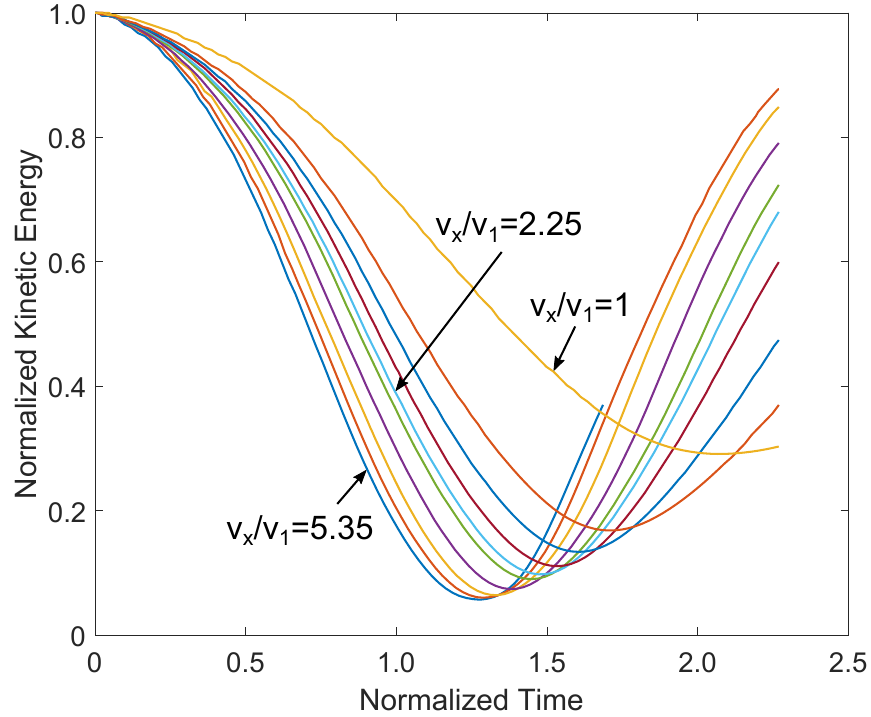
Figure 11. Normalized kinetic energy of the numerical model, with respect to normalized time, for the different velocities of the killer whale at x -direction; v y = 1 m/s for each